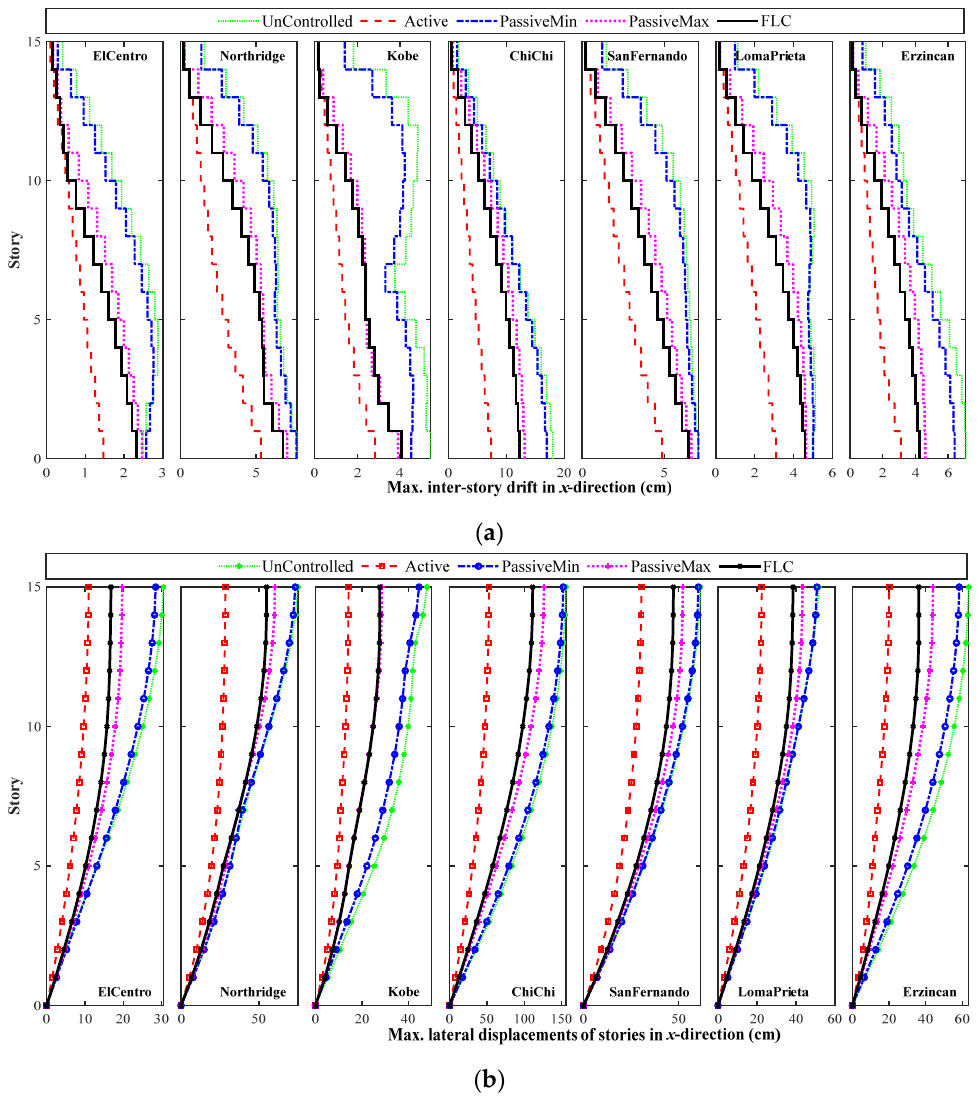
Figure 13. Maximum lateral inter-story drifts, ( a ), and maximum lateral displacements, ( b ), of the Case-I building in the x -direction (rock base).